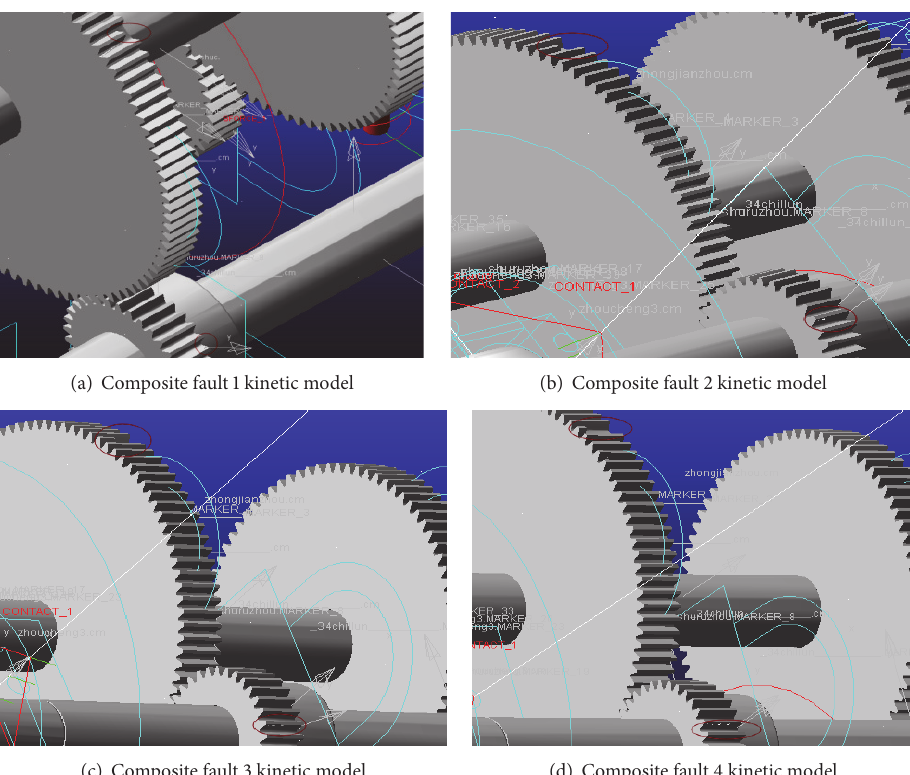
Figure 2: Dynamics model of the gear broken teeth-pitting compound